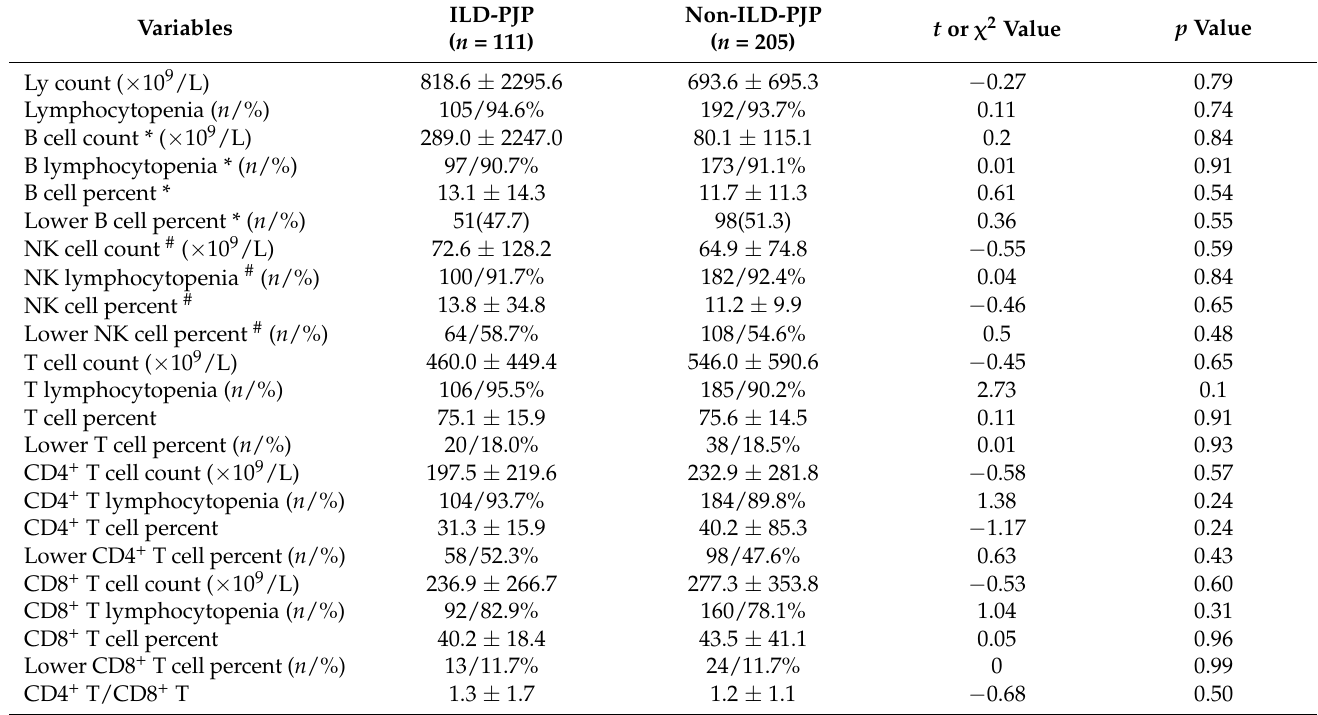
Table 3. Peripheral lymphocyte subset analysis.